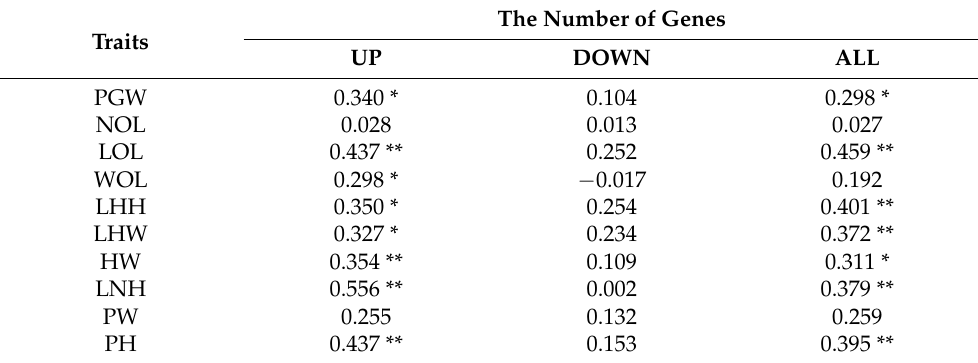
Table 4. The correlation between the number of parental differentiall expression genes and observed value of traits in hybrids.